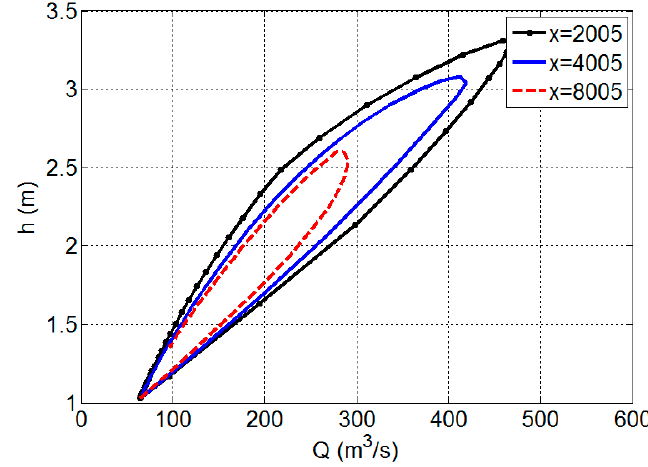
Figure 11. Wave attenuation: channel rating curve.